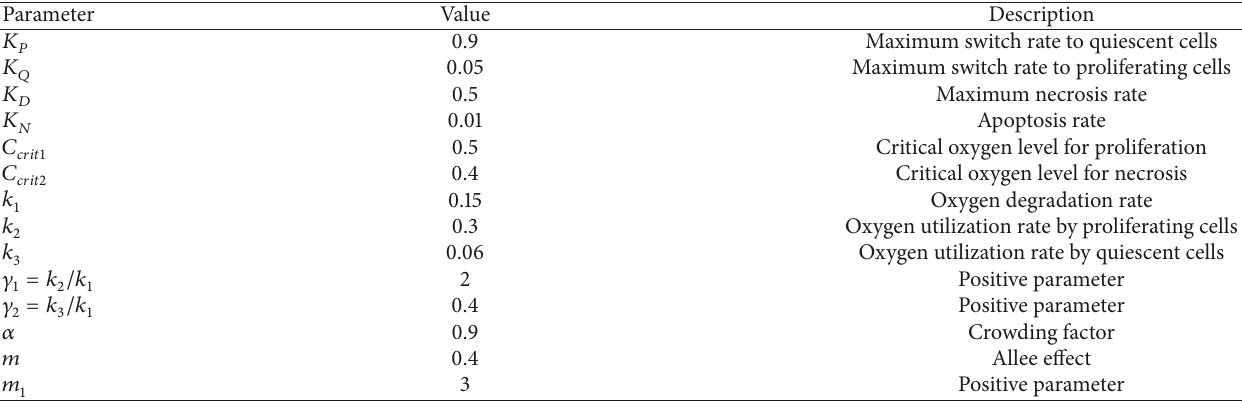
Table 1: Dimensionless parameter values used in our